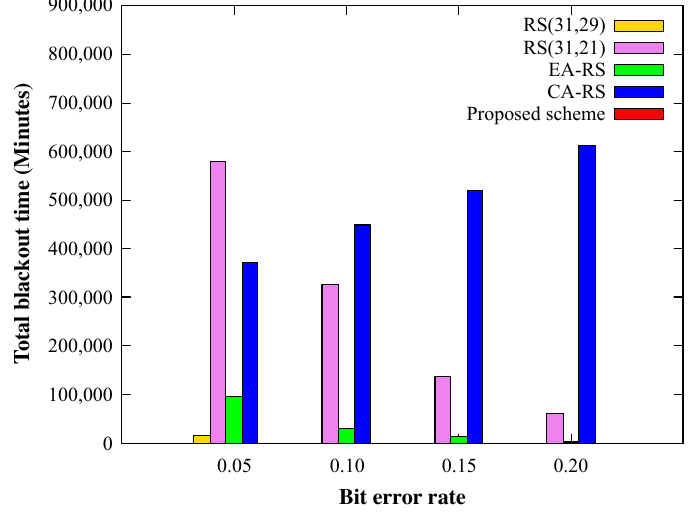
Figure 14. Blackout during entire time for varying BER (node